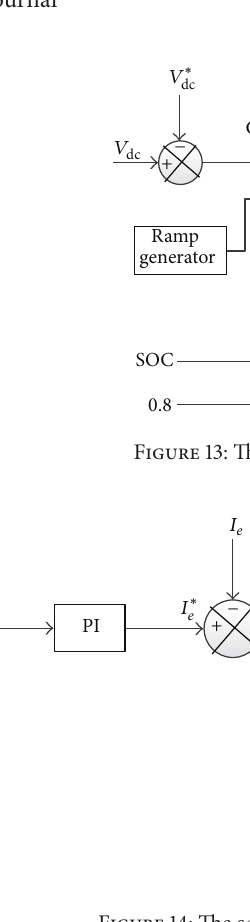
Figure 14: The schematic diagram of emergency backup